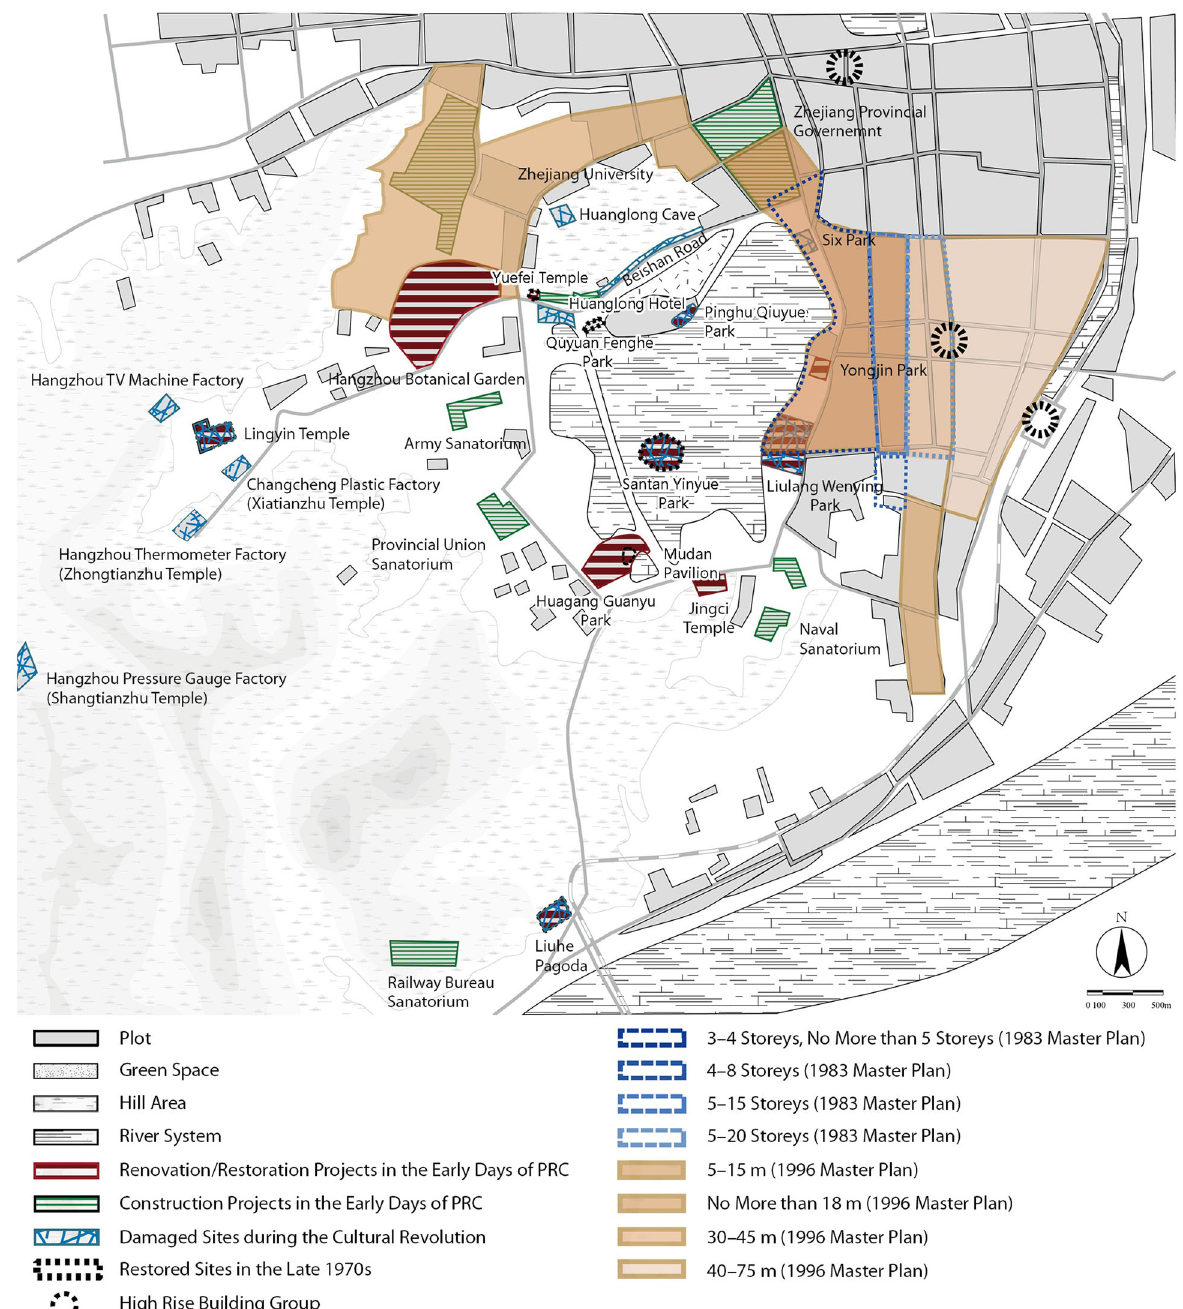
Fig. 3 Urbanisation and Conservation in the West Lake Area (Source: the authors. Data are from archives of the Hangzhou Municipal Bureau of Gardening and Cultural Relics and Hangzhou